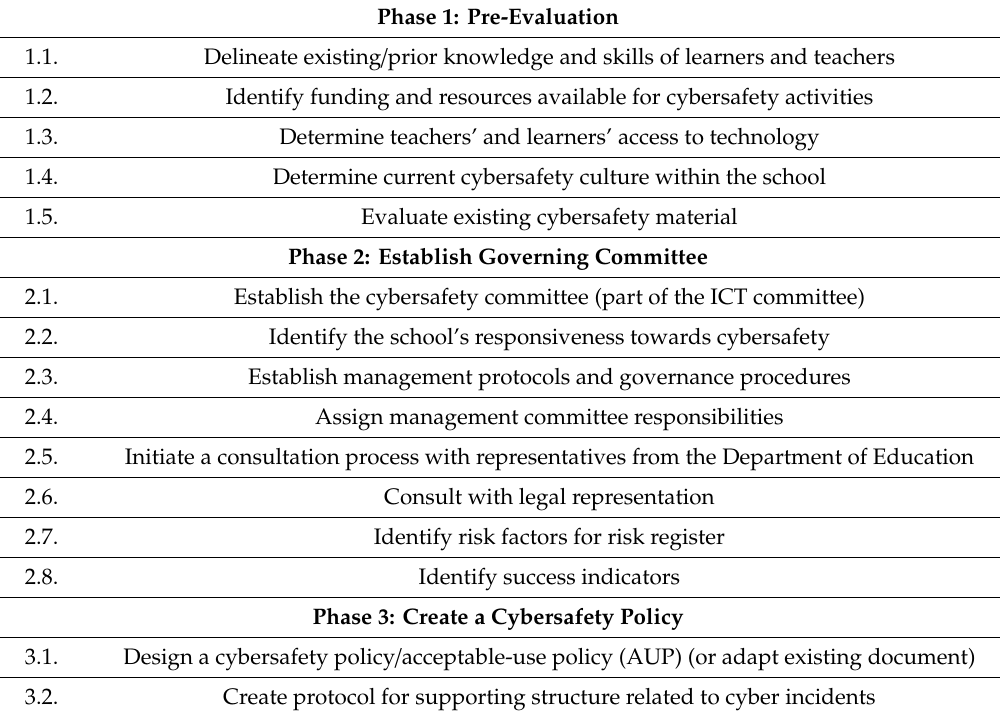
Table 2. Ten-phase approach to